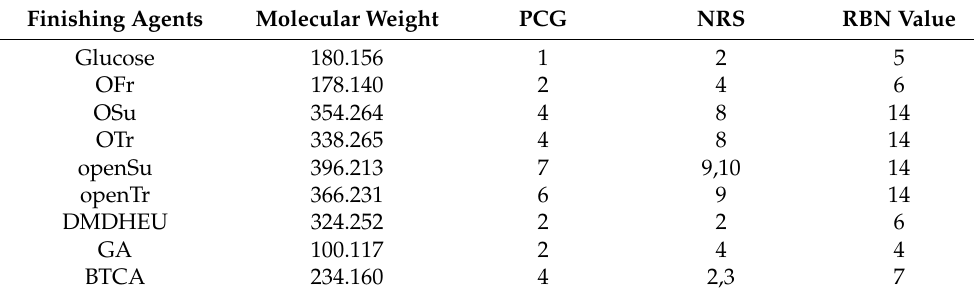
Figure 6. Molecular structure of different finishing agents at the minimum energy. Table 1. Comparison of cross-linking properties of different finishing agent